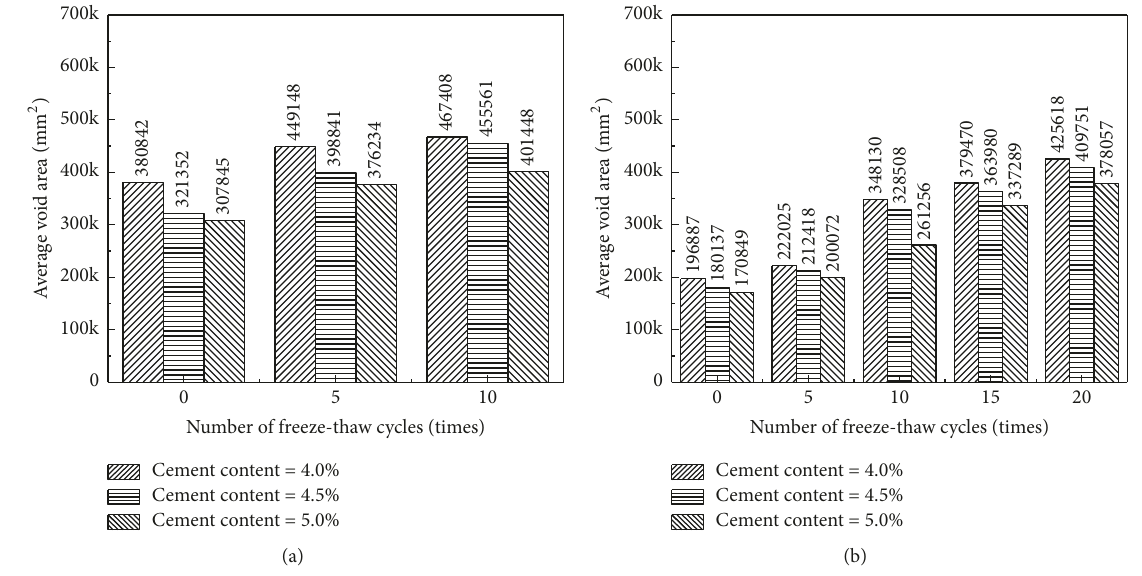
Figure 6: Effects of the number of freeze-thaw cycles, cement content, and curing time on the average void area: (a) curing time = 28d; (b) curing time =